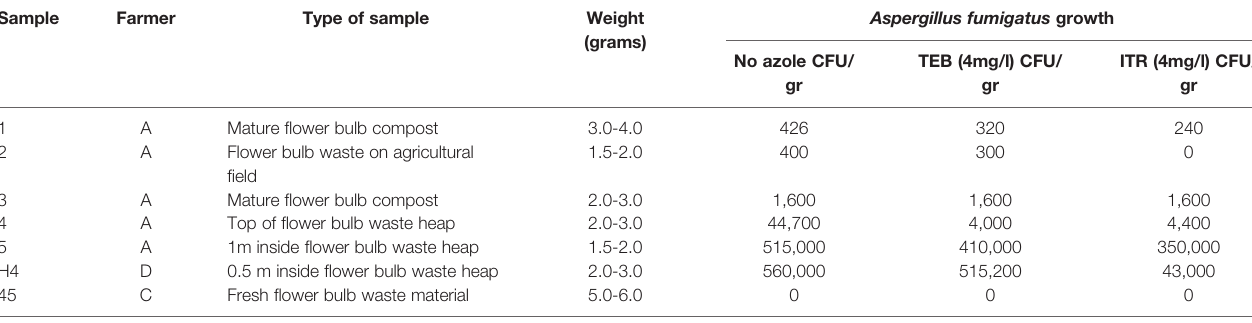
TABLE 1 | Sample characteristics of selected fl ower bulb waste material samples for sexual crossing experiments from (Zhang et al., 2017; Zhang et al., 2021b). Sample